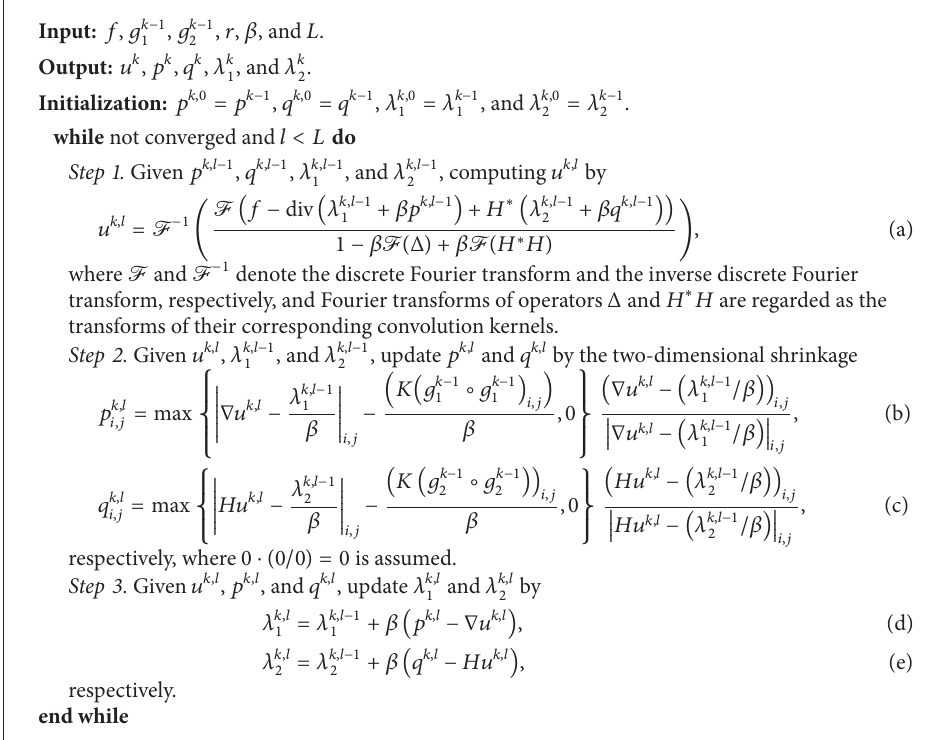
Algorithm 3: The alternating minimization method for solving